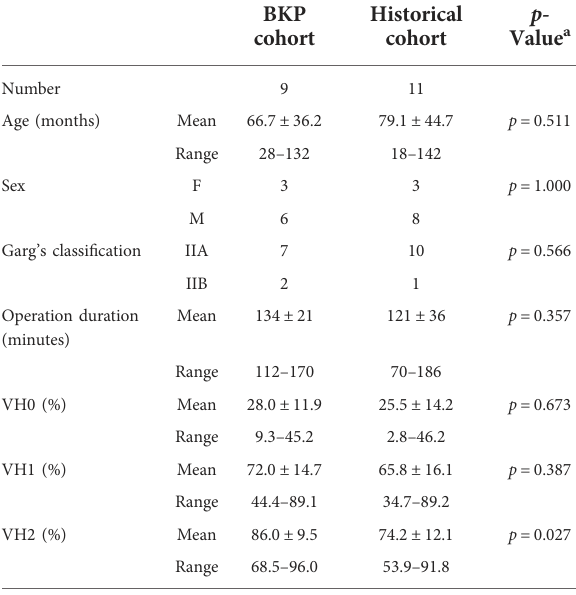
TABLE 4 Clinical data of BKP cohort in comparison with the historical control cohort.